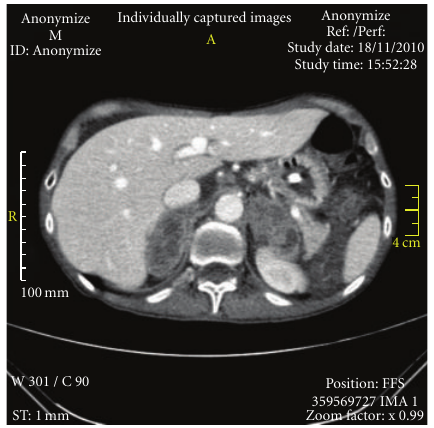
Figure 2: Abdominal computed tomography scan. It showed mas- sive heterogeneous lesions in both adrenals, measuring about 5cm in each greatest